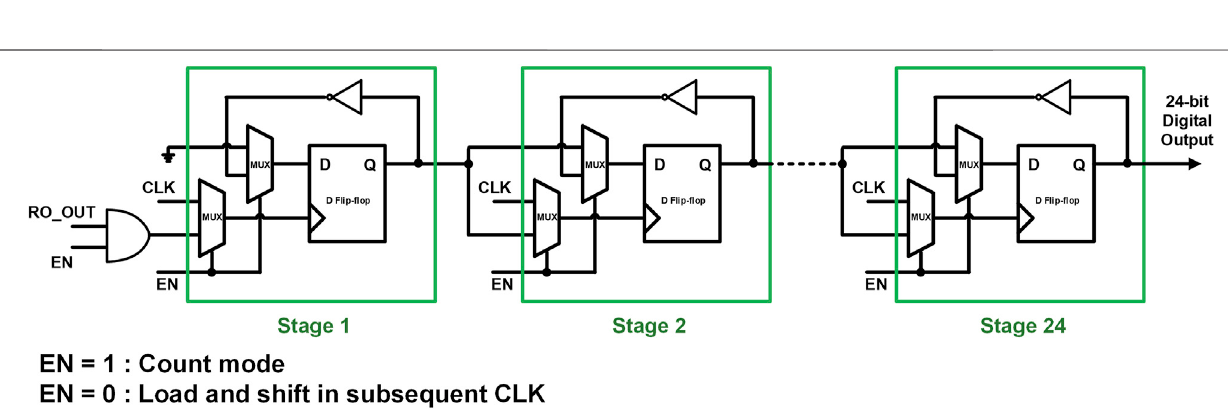
Frontiers in Electronics |